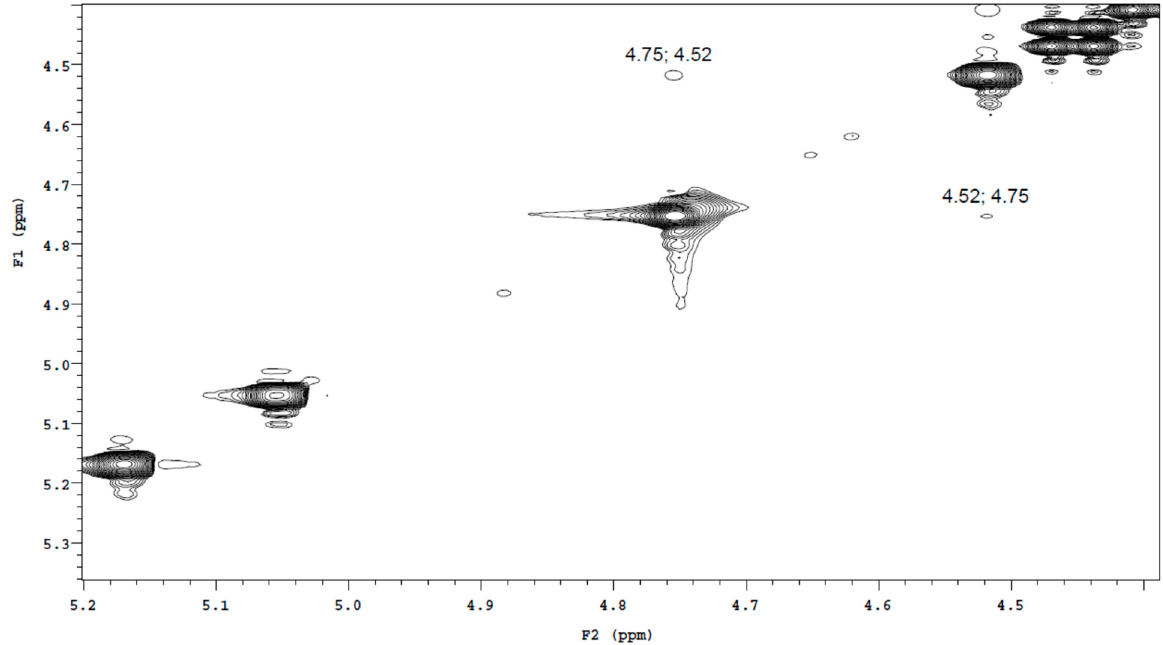
Figure 2. 1 H- 1 H ROESY spectrum fragment of the Bud-API solution in DMSO-d6. Figure 2. 1 Н - 1 Н ROESY spectrum fragment of the Bud-API solution in DMSO-d6.